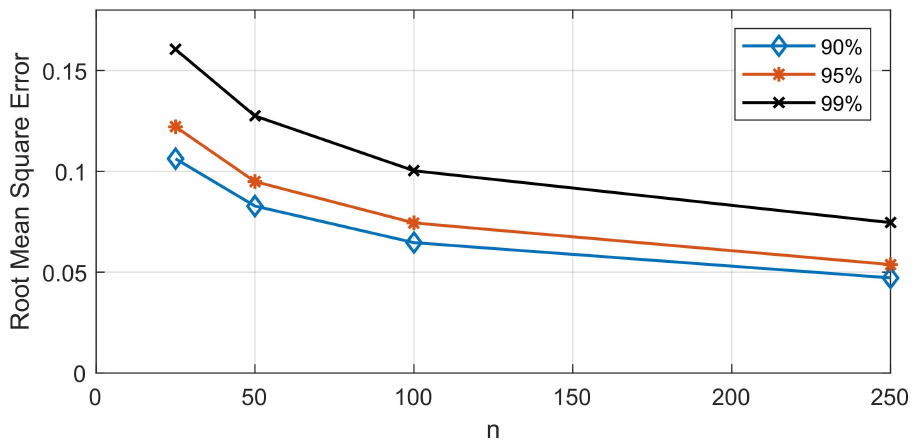
Figure 13. RMSE as a function of sampling length (n) for 90%, 95%, and 99%